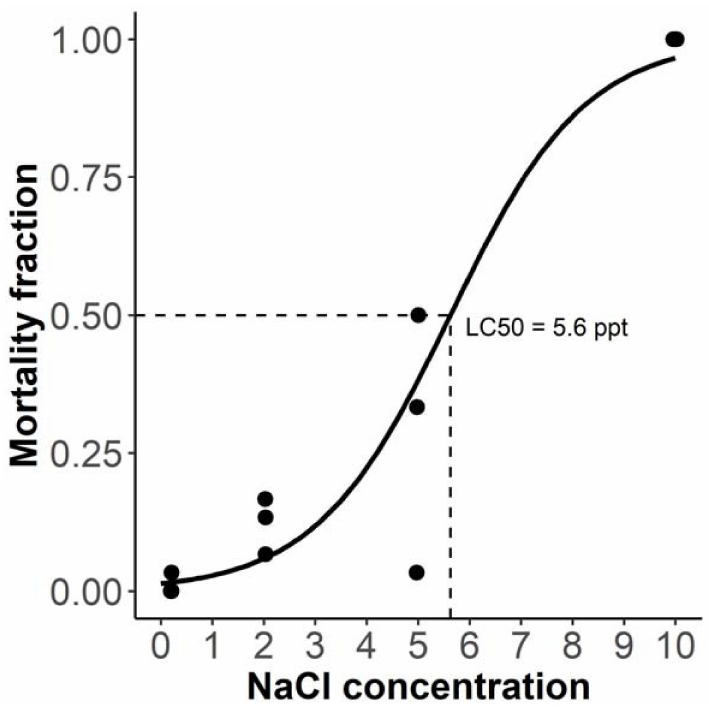
Figure 1. Concentration–response relationship between salinity (salt concentration in parts per thousand) and embryo mortality % after 24 h of exposure beginning from <2 h post-fertilisation. N = 3 dishes of 30 embryos per treatment level, with each point representing a single dish. Curve fit and predicted LC50 were obtained using a generalised linear